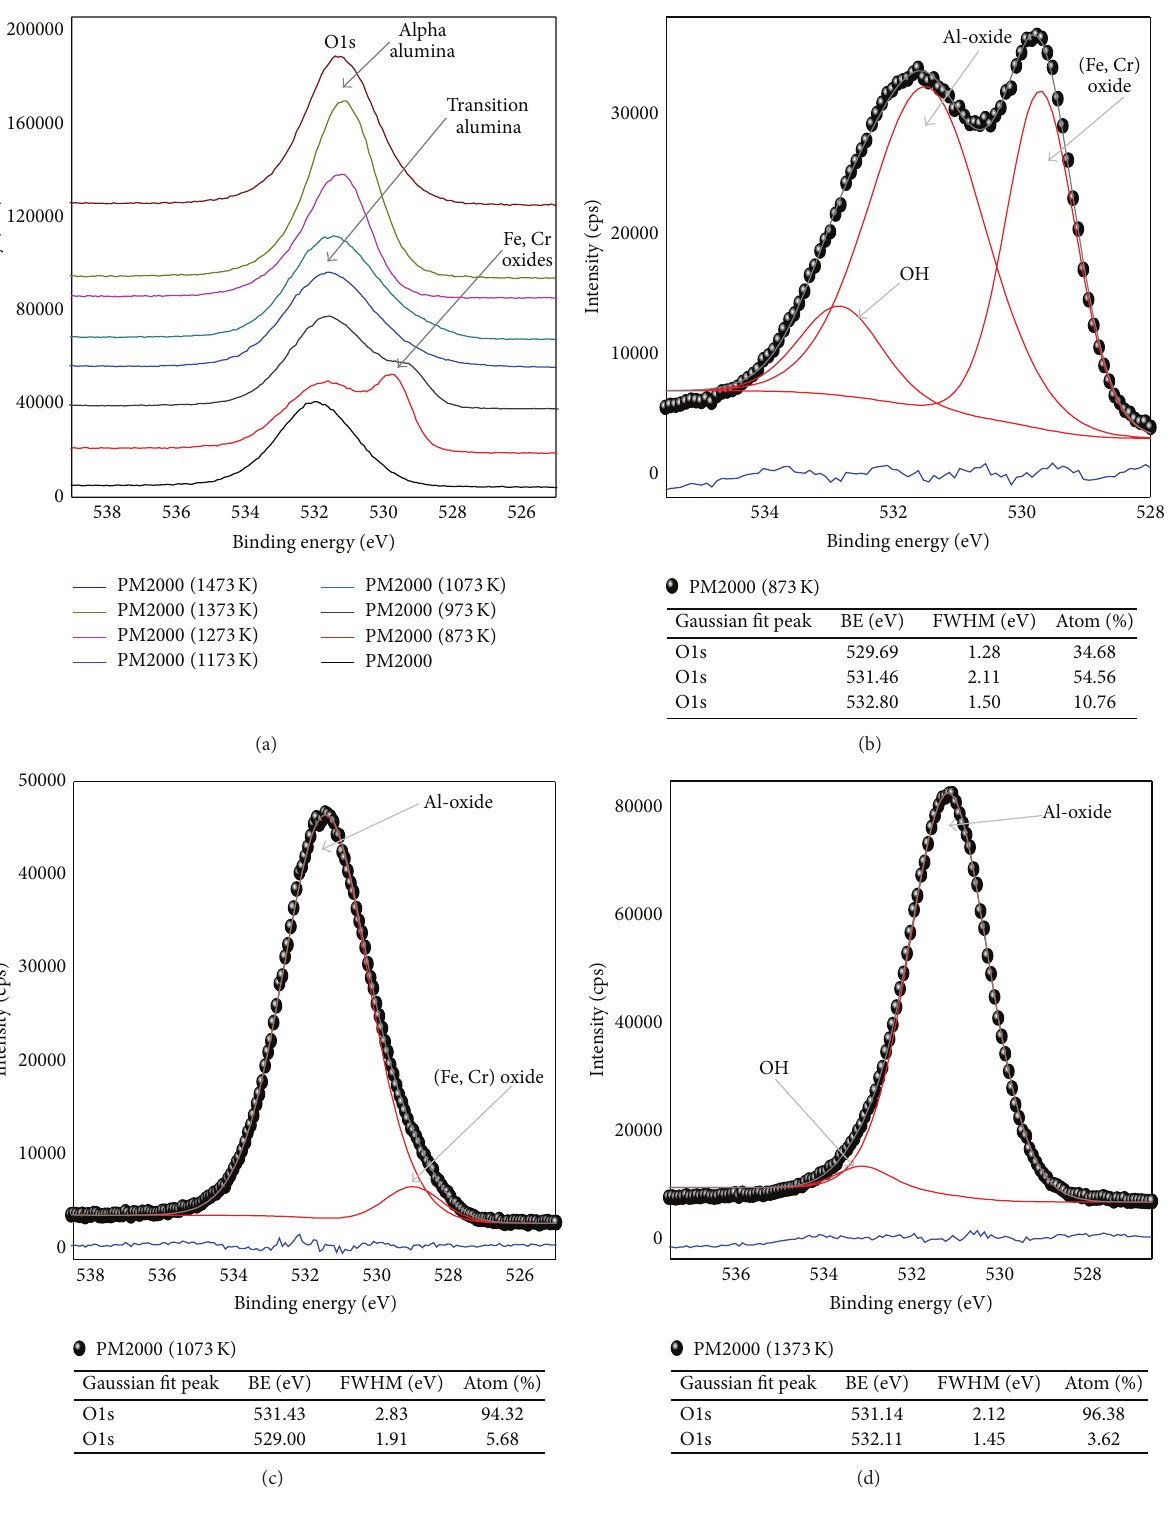
Figure 10: XPS spectra in the O1s region for as-received and treated PM2000 at various temperatures (a), decomposed O1s peaks of oxidized PM2000 at 873 K (b), decomposed O1s peaks of oxidized PM2000 at 1073K (c), and decomposed O1s peaks of oxidized PM2000 at 1373 K